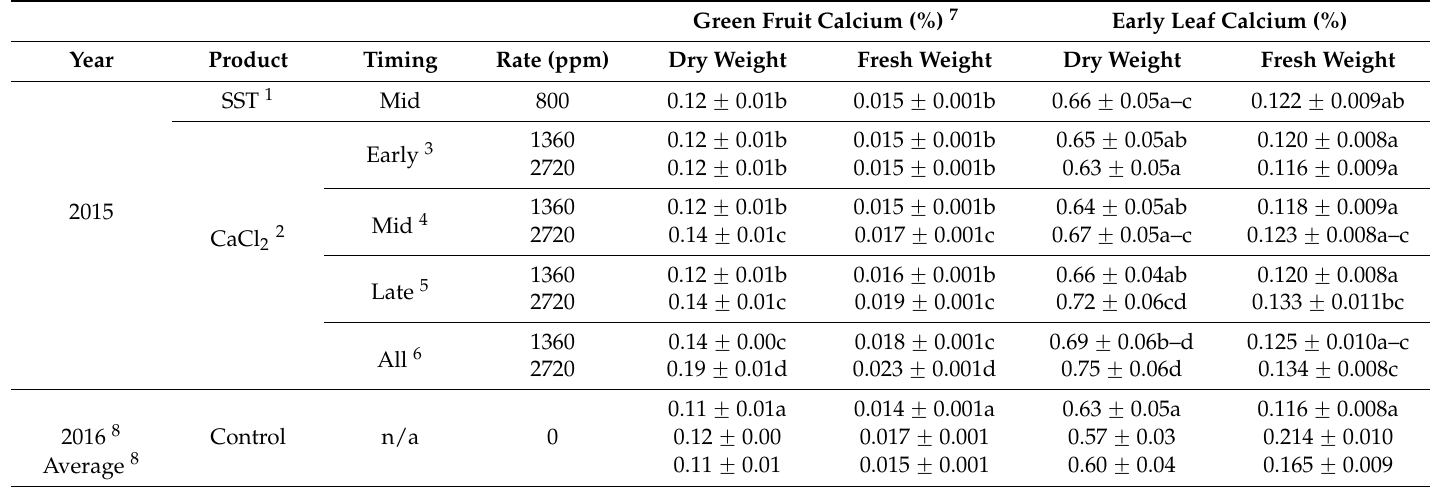
Table 4. Mean ˘ SE green fruit and early leaf calcium concentrations in ‘Draper’ highbush blueberry in response to foliar Ca products, application timings and rates across three sites in the Fraser Valley, British Columbia, Canada in 2015 as well as for control plots in